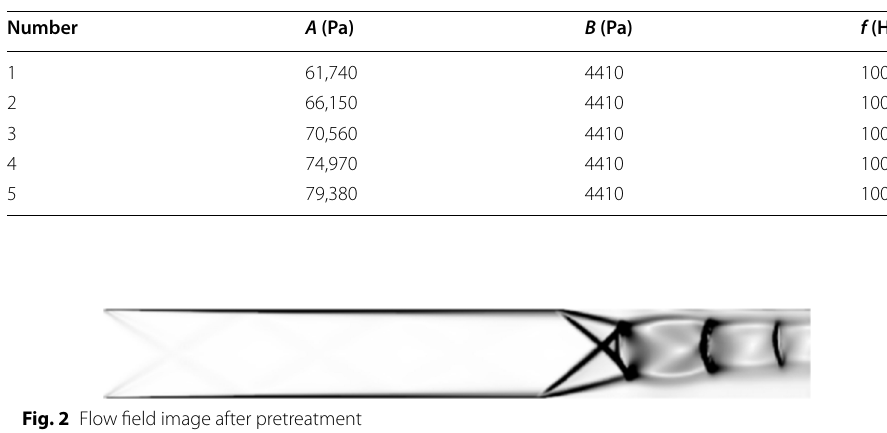
Table 1 Back pressure conditions